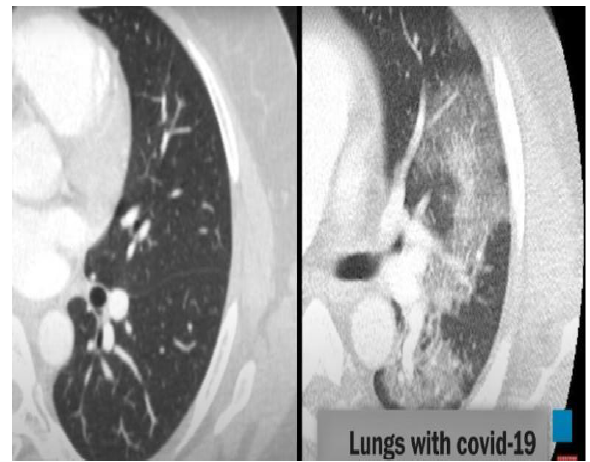
Figure 2.1: This is the chest CT scan of a covid positive pneumonia patient.[3]